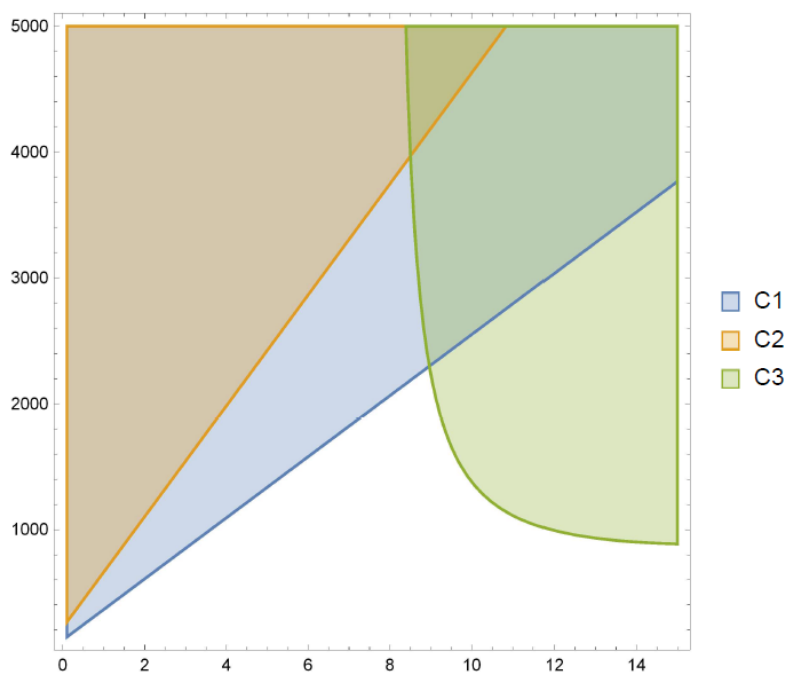
Figure 1. Regions for which Conditions (32)–(34) are satisfied when a = 1/2 and b = 1/3.